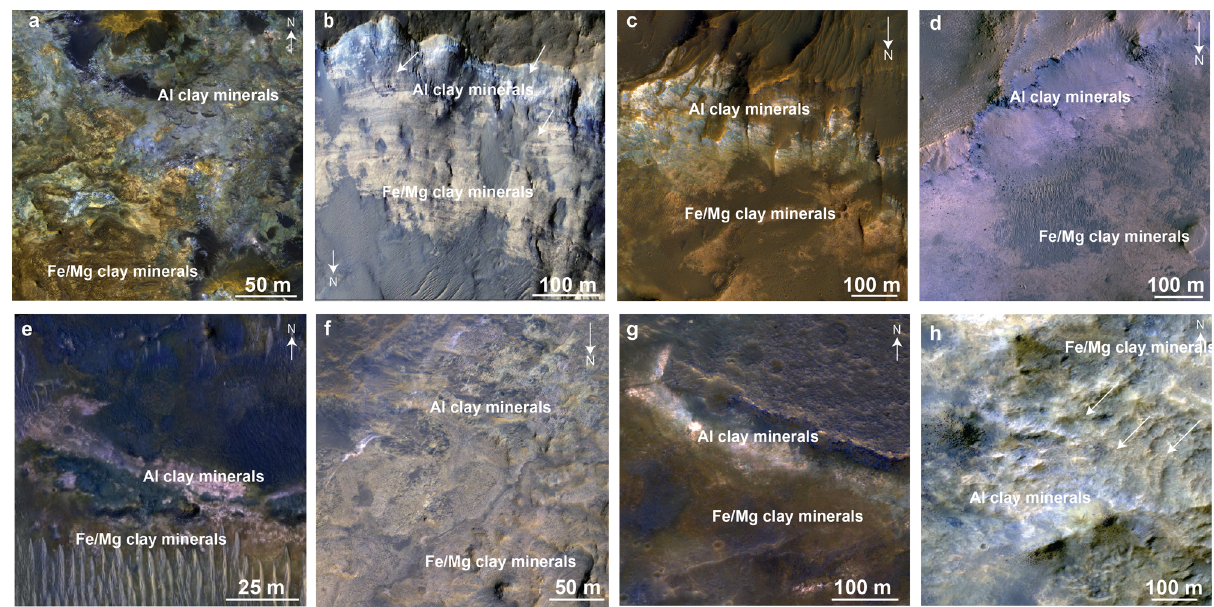
Fig. 2 Characteristics of representative geological contacts in martian weathering pro fi les. HiRISE IRB data (infrared, red, and blue-green) reveal submeter compositional differences of geological contacts of weathering pro fi les in false color. a Mawrth Vallis; b Northern Hellas Basin region; c Eridania northern basin; d Noachis Terra; e Nili Fossae region; f Terra Tyrrhen; g Valls Marineris; h Simois colles. HiRISE High-Resolution Imaging Science